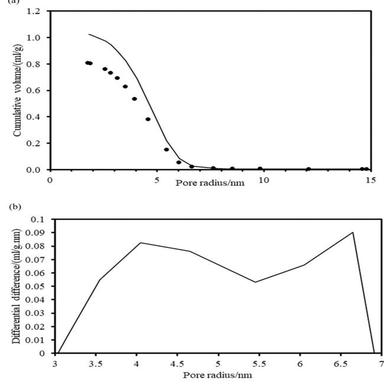
(a) Cumulative BJH PSDs, using a value of k = 1 in, obtained from nitrogen adsorption isotherms for G1 after the pellets had been initially dried at 350 ◦C (solid line), and also following pre-adsorption of water to a relative humidity of 0.85 and mercury porosimetry (•). (b) Differential difference plot obtained from the two PSDs shown in (a).